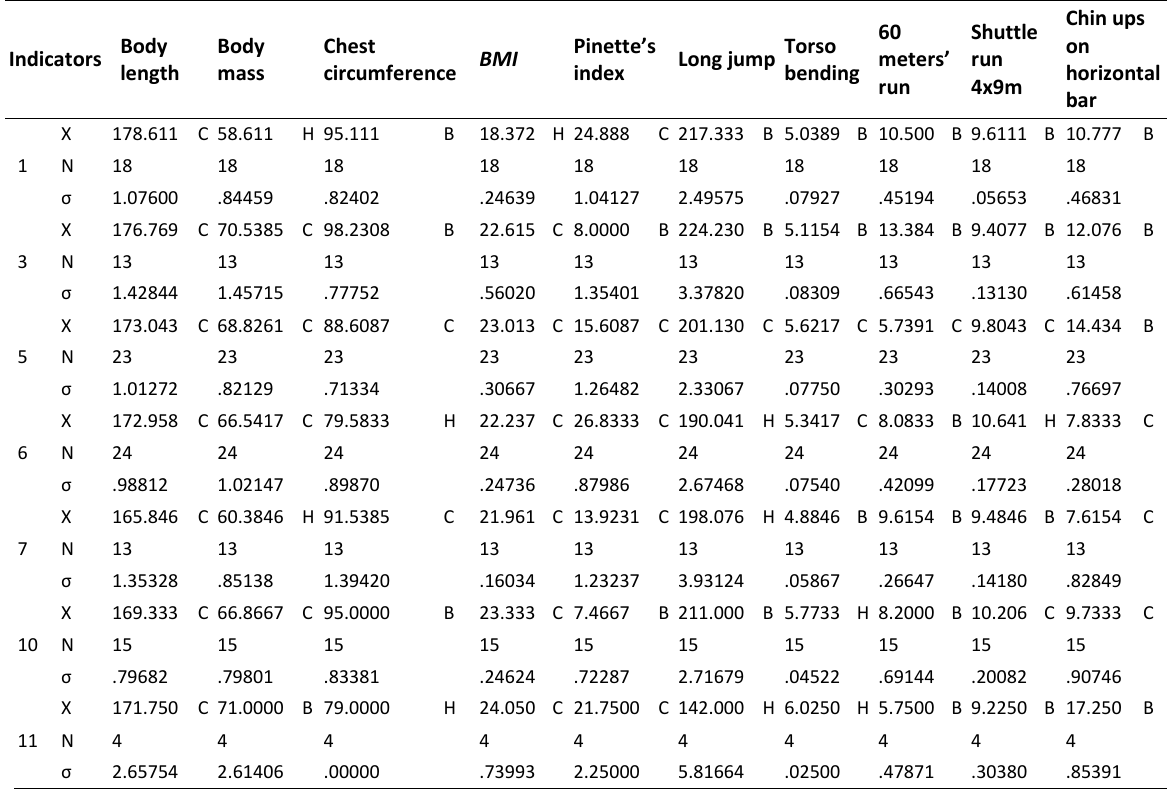
Table 3. Results of cluster analysis